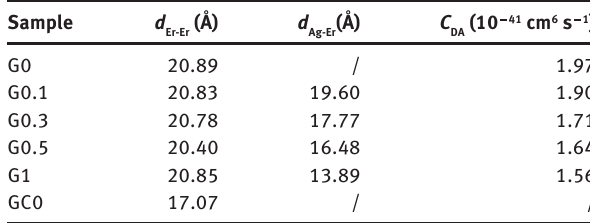
Table 1: The average distances of Er 3 + -Er 3 + and Ag + -Er 3 + ion pairs and the energy transfer coefficients of Er 3 + : 4 I energy transfer